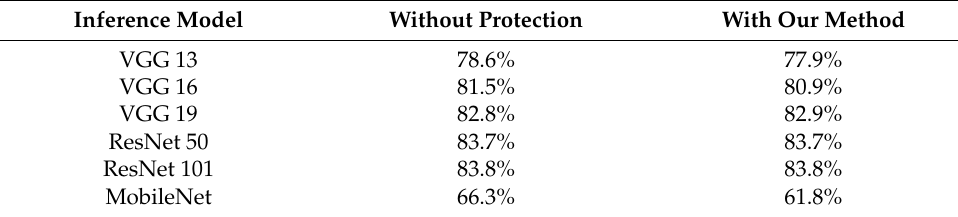
Table 5. Recall quantisation on our method.